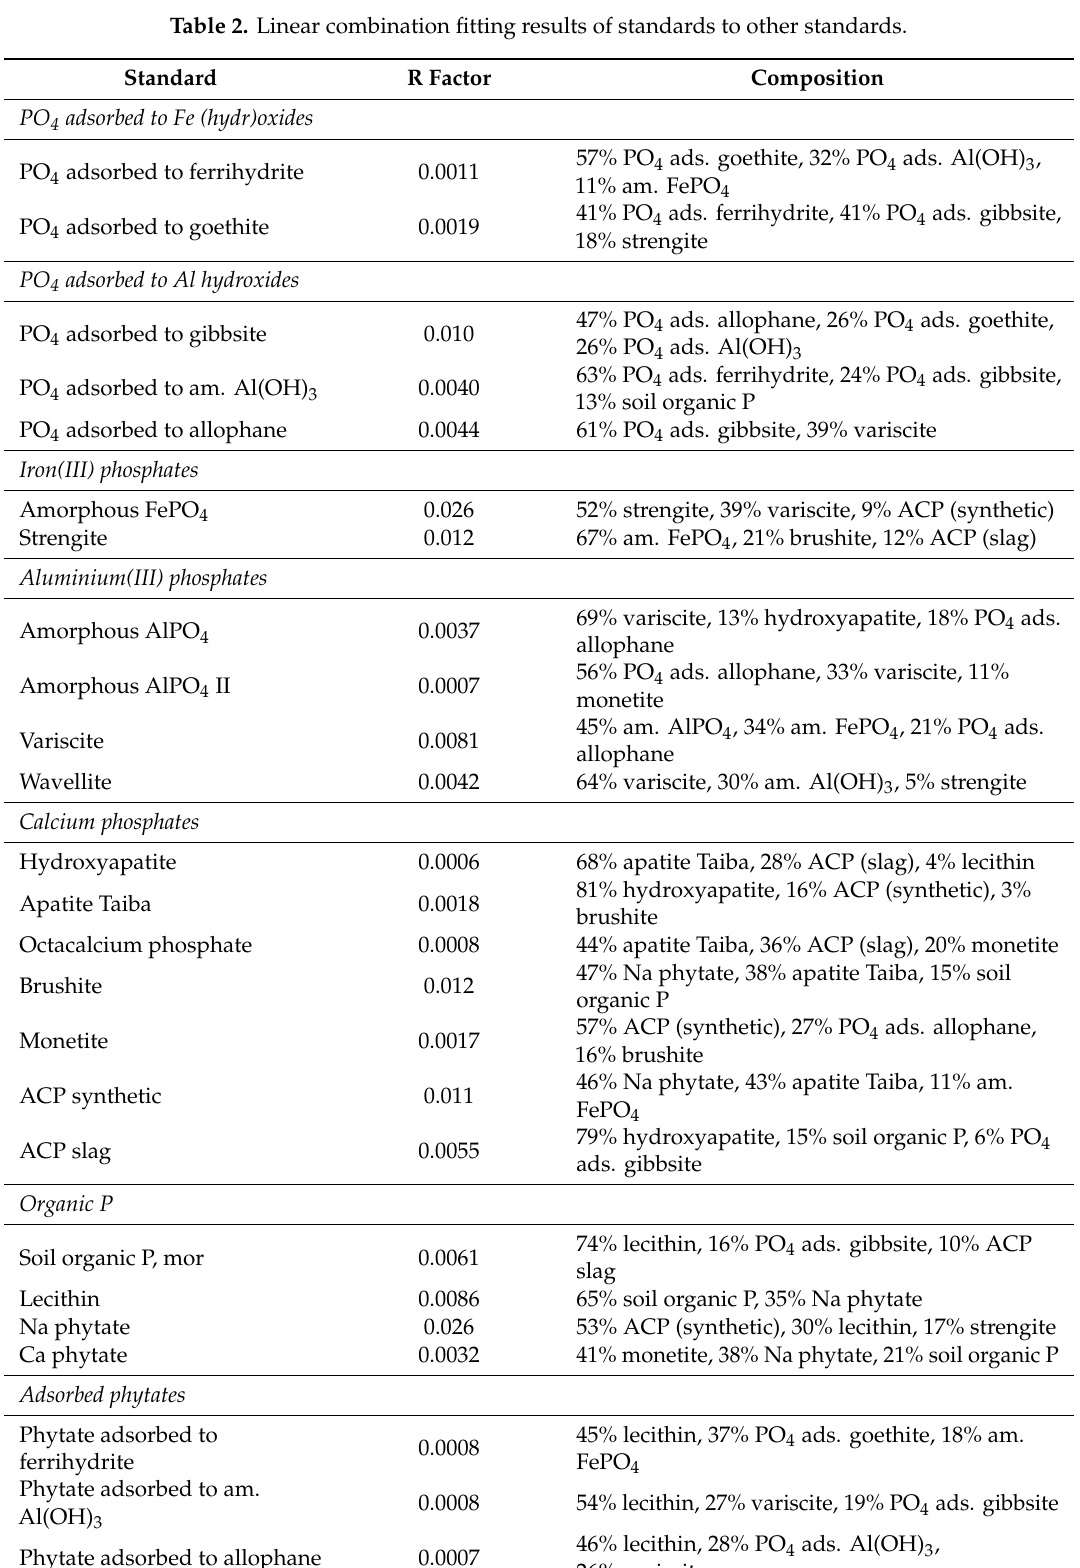
Table 2. Linear combination fitting results of standards to other